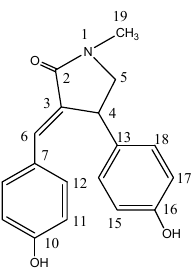
Figure 1. Chemical structure of the pyrrolidine alkaloid isolated from the ethanol extract of O. japonica root barks.